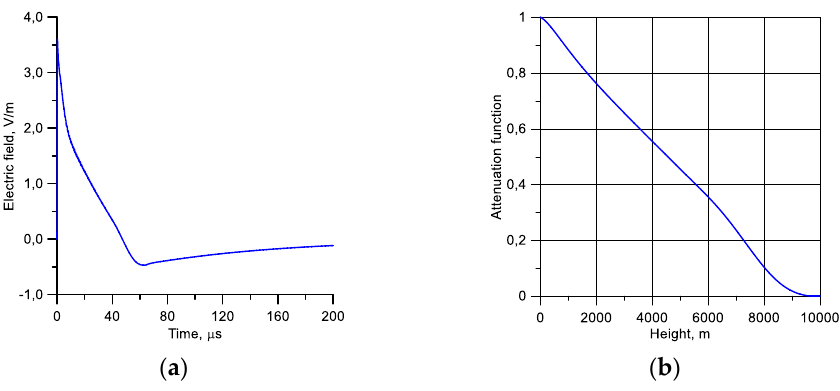
Figure 4. ( a ) Radiation field assumed to represent the subsequent return stroke radiation fields in the tropics. ( b ) Current attenuation function pertinent to the radiation field shown in Figure 4a.